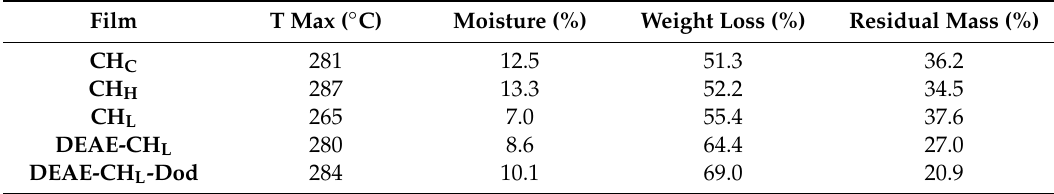
Figure 2. TGA and DTGA curves for films of ( a , b ) commercial (CH C ) and deacetylated chitosans (CH H and CH L ) and ( c , d ) the amphiphilic derivatives (DEAE-CH L and DEAE-CH L -Dod) of chitosan. (Upward arrow indicates increasing stability; Downward arrow indicates decreasing residual mass). Table 2. Maximum degradation temperature (Tmax) values and percentages of weight loss and residual mass for the